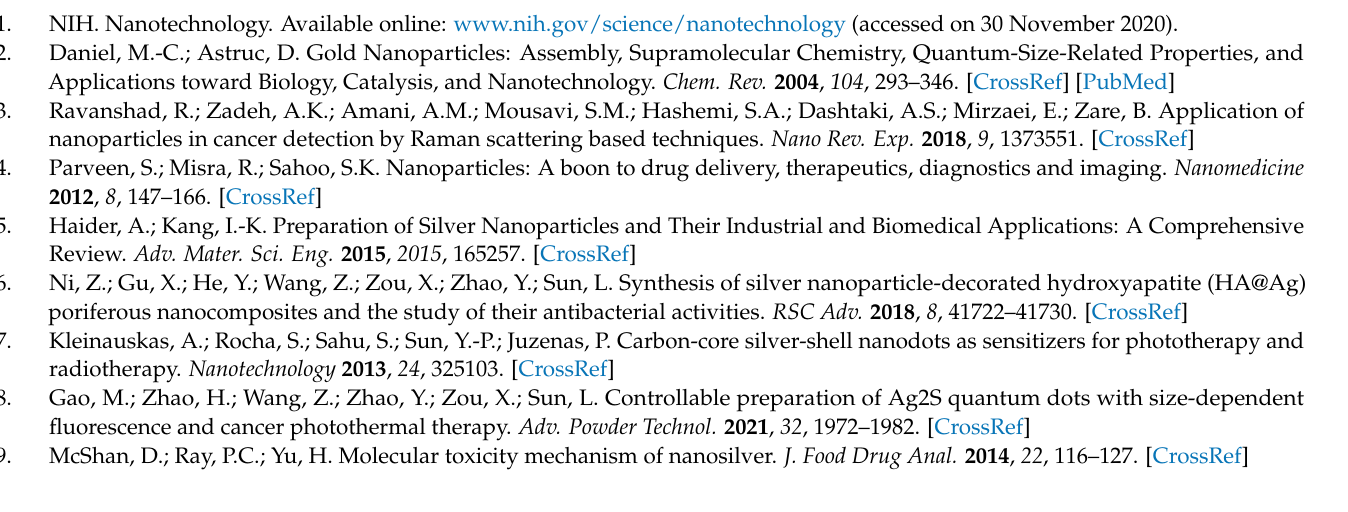
treatment; Figure S5: TEM images presenting ultrastructural changes of the nervous tissue in the hippocampus, recorded 15 days after the end of the experimental